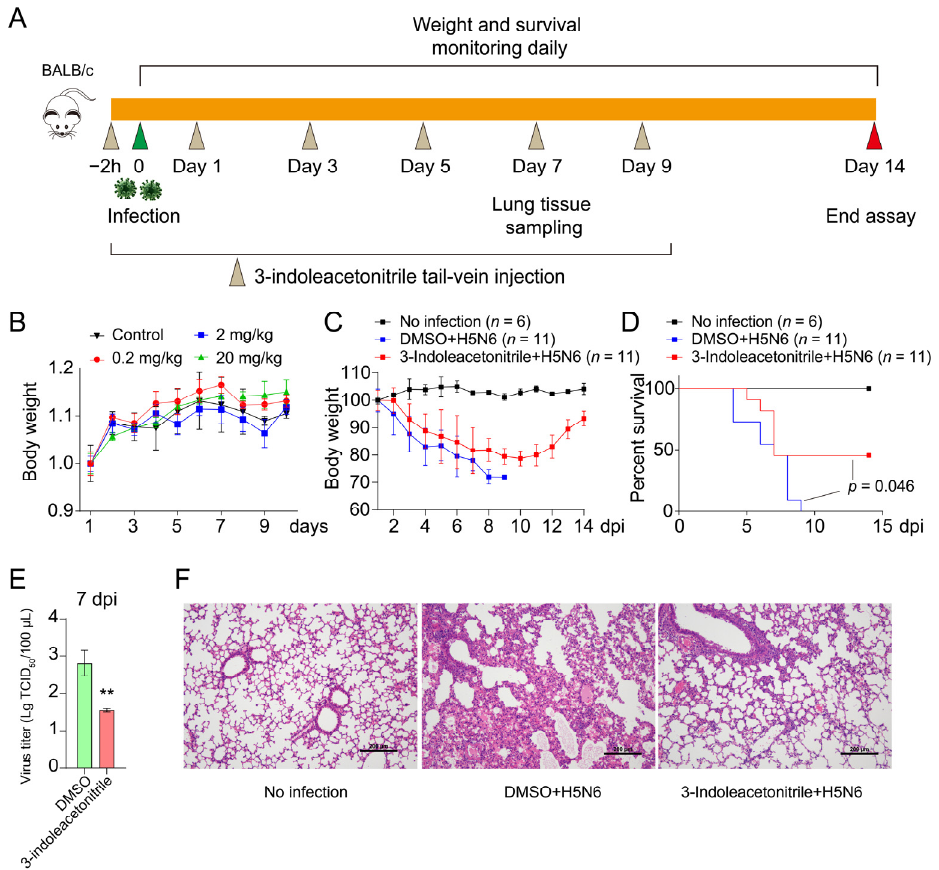
Figure 5. 3-indoleacetonitrile restricts H5N6 virus replication in mice. ( A ) Schematic diagram of the mouse experiment. ( B ) Female BALB/c mice were treated with 3-indoleacetonitrile (0.2, 2 or 20 mg/kg per day) or 0.5% DMSO via tail-vein injection. Body weights in each group were monitored daily for 10 days post-treatment. ( C – F ) Female BALB/c mice were inoculated with 50 μ L of 2 LD 50 H5N6 viruses and treated with 20 mg/kg 3-indoleacetonitrile or 0.5% DMSO. In the next 2 weeks, the body weights ( C ) and mouse survival ( D ) were recorded daily. p -value was calculated using the log-rank (Mantel–Cox) test. On 7 dpi, the left lung’s viral titers ( E ) were measured by determining the TCID 50, and the right lungs were fixed for H&E staining ( F ). ** p < 0.01; calculated from